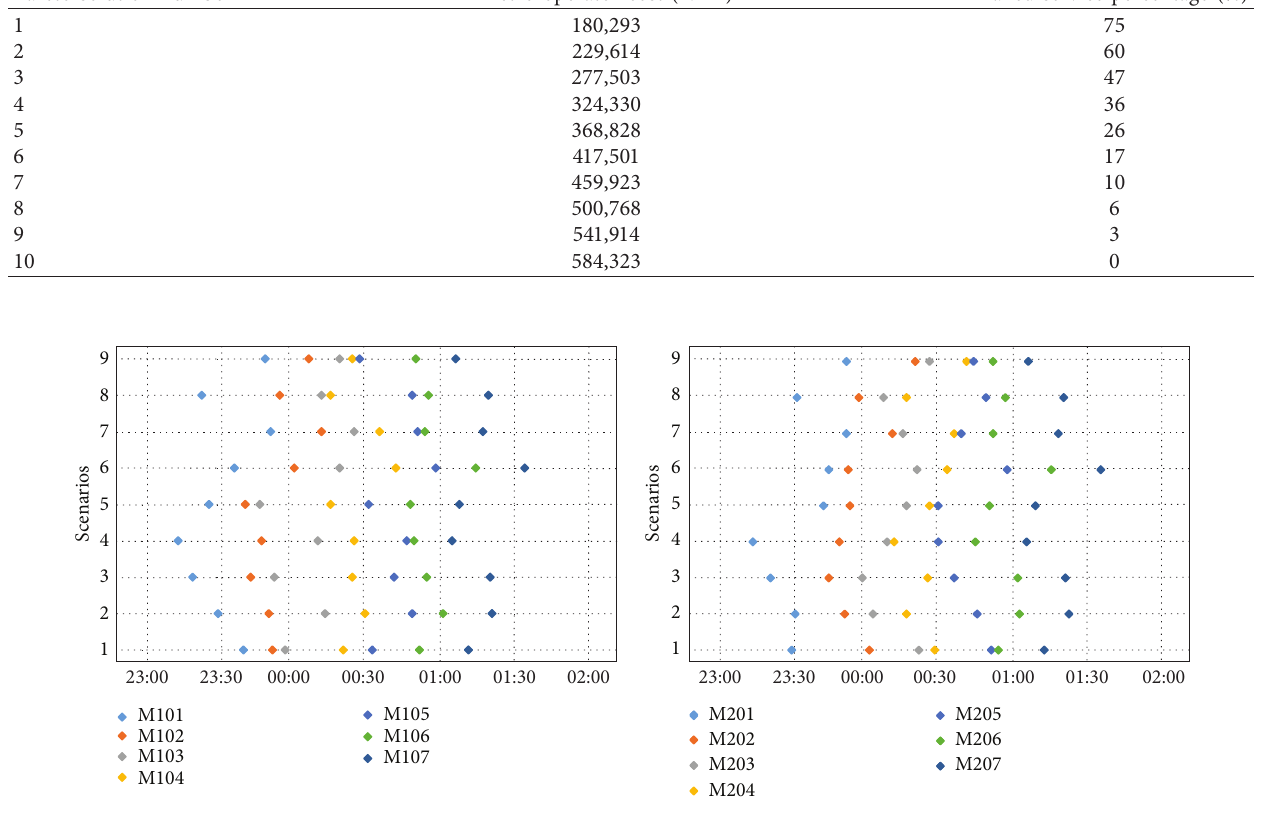
Table 6: Expected metro operator cost and passenger cost for the 10 Pareto-optimal solutions. Pareto solution